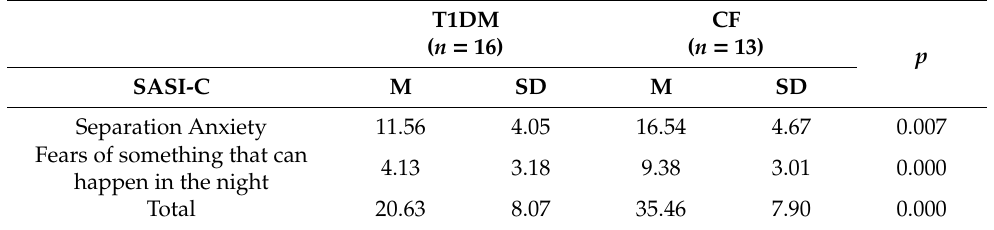
Table 3. Mann–Whitney U test for SASI-C variables between T1DM and CF groups.